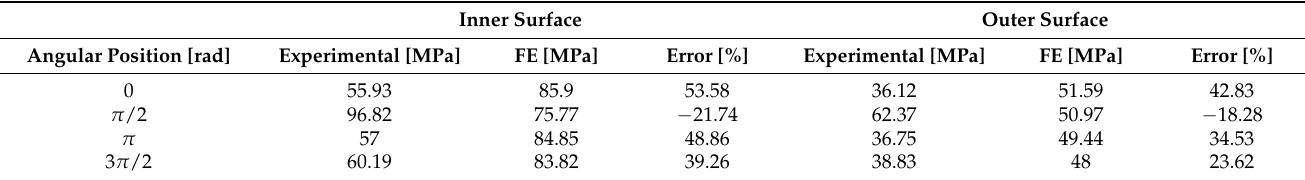
Table 5. Comparison of hoop stress in the test boss on both inner and outer surfaces. Inner